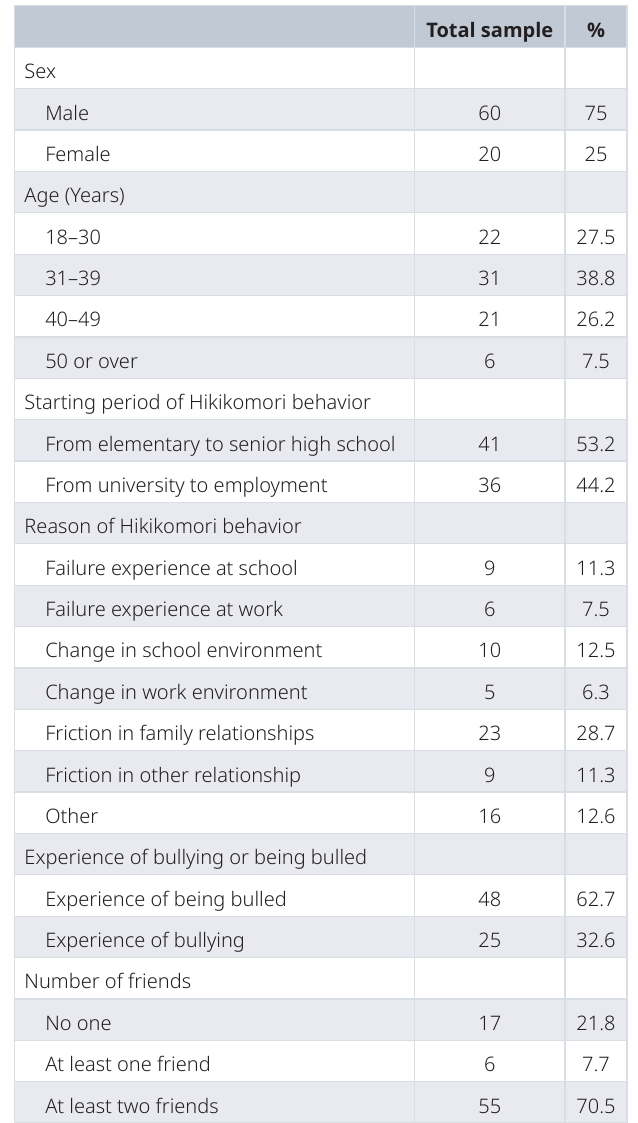
Table 1. Descriptive statistics of